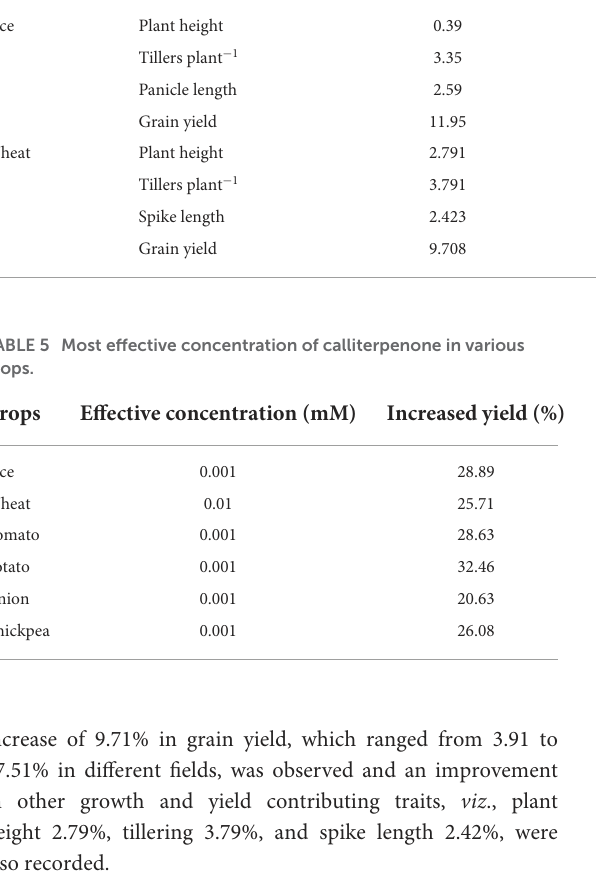
TABLE 4 Effect of calliterpenone on growth and yield of rice and wheat at farmers’ field. Crops